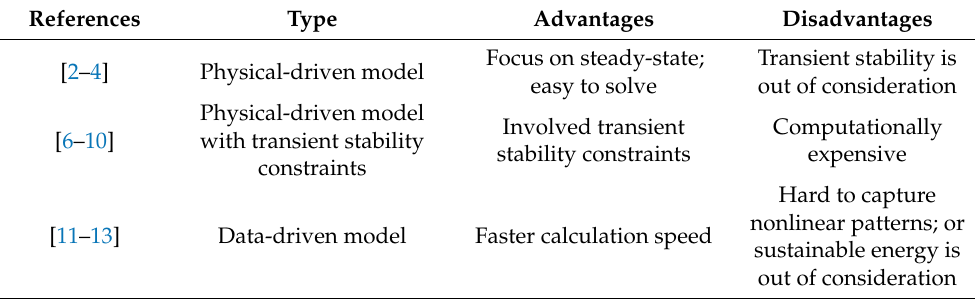
Table 1. A comparison table with the advantages and disadvantages of each